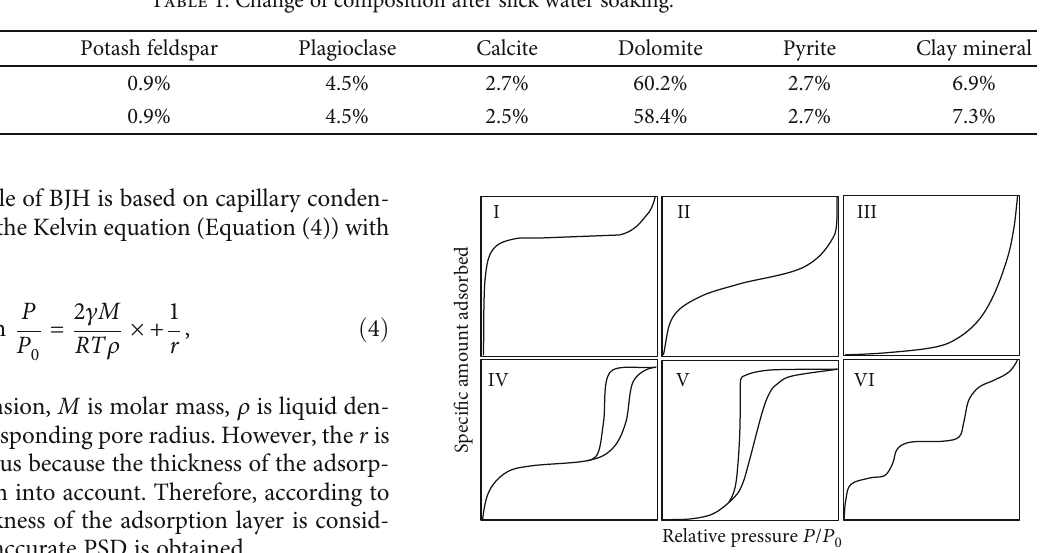
Table 1: Change of composition after slick water soaking.